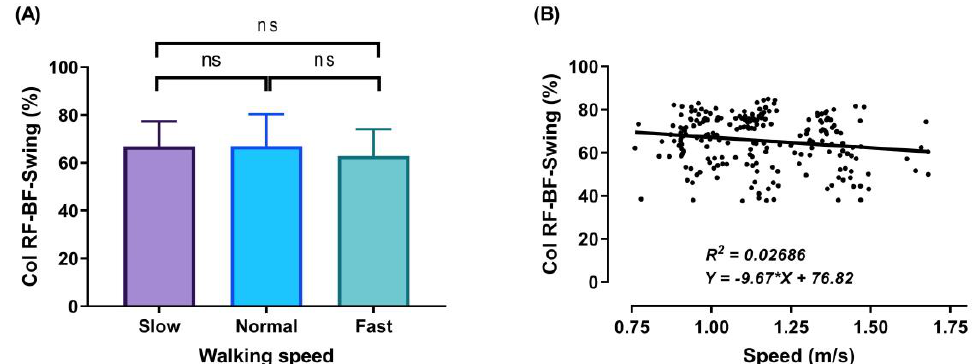
Figure 9. Mean of thigh muscles (RF-BF) co-activation at different walking speeds (slow, normal, and fast) during walking phases: Swing ( A ). ANOVA results showing the effects of changing in CoI of thigh muscles during walking speed (slow, normal, and fast). Correlation between walking speed and thigh muscles (RF-BF) co-activation during Swing walking phase ( B ). Asterisk signs above the line represent significant differences between walking speed: (ns) indicates non-sig- nificant.